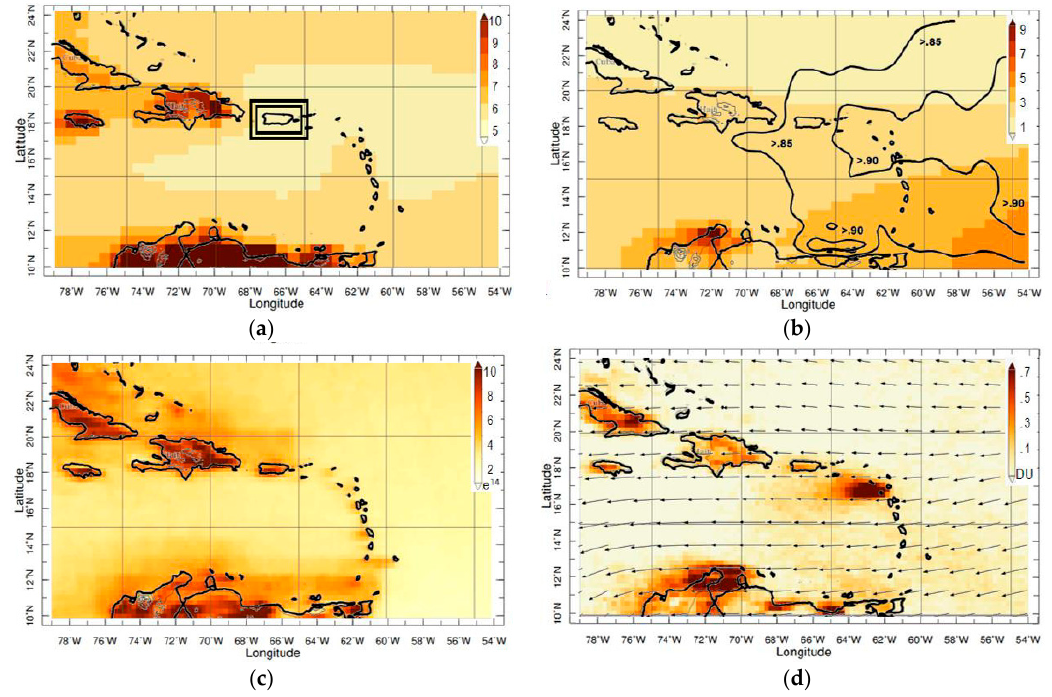
Figure 2. Mean (2005–2015) maps of near-surface: ( a ) MERRA2 CO in 10 − 6 g/kg with index area (box), ( b ) MERRA2 aerosol PM 2.5 shaded (10 − 6 g/m 3 ) and OMI UV aerosol index (contour > 0.85), ( c ) OMI NO 2 10 15 molecules/cm 2 , and ( d ) OMI SO 2 in DU with wind vectors.